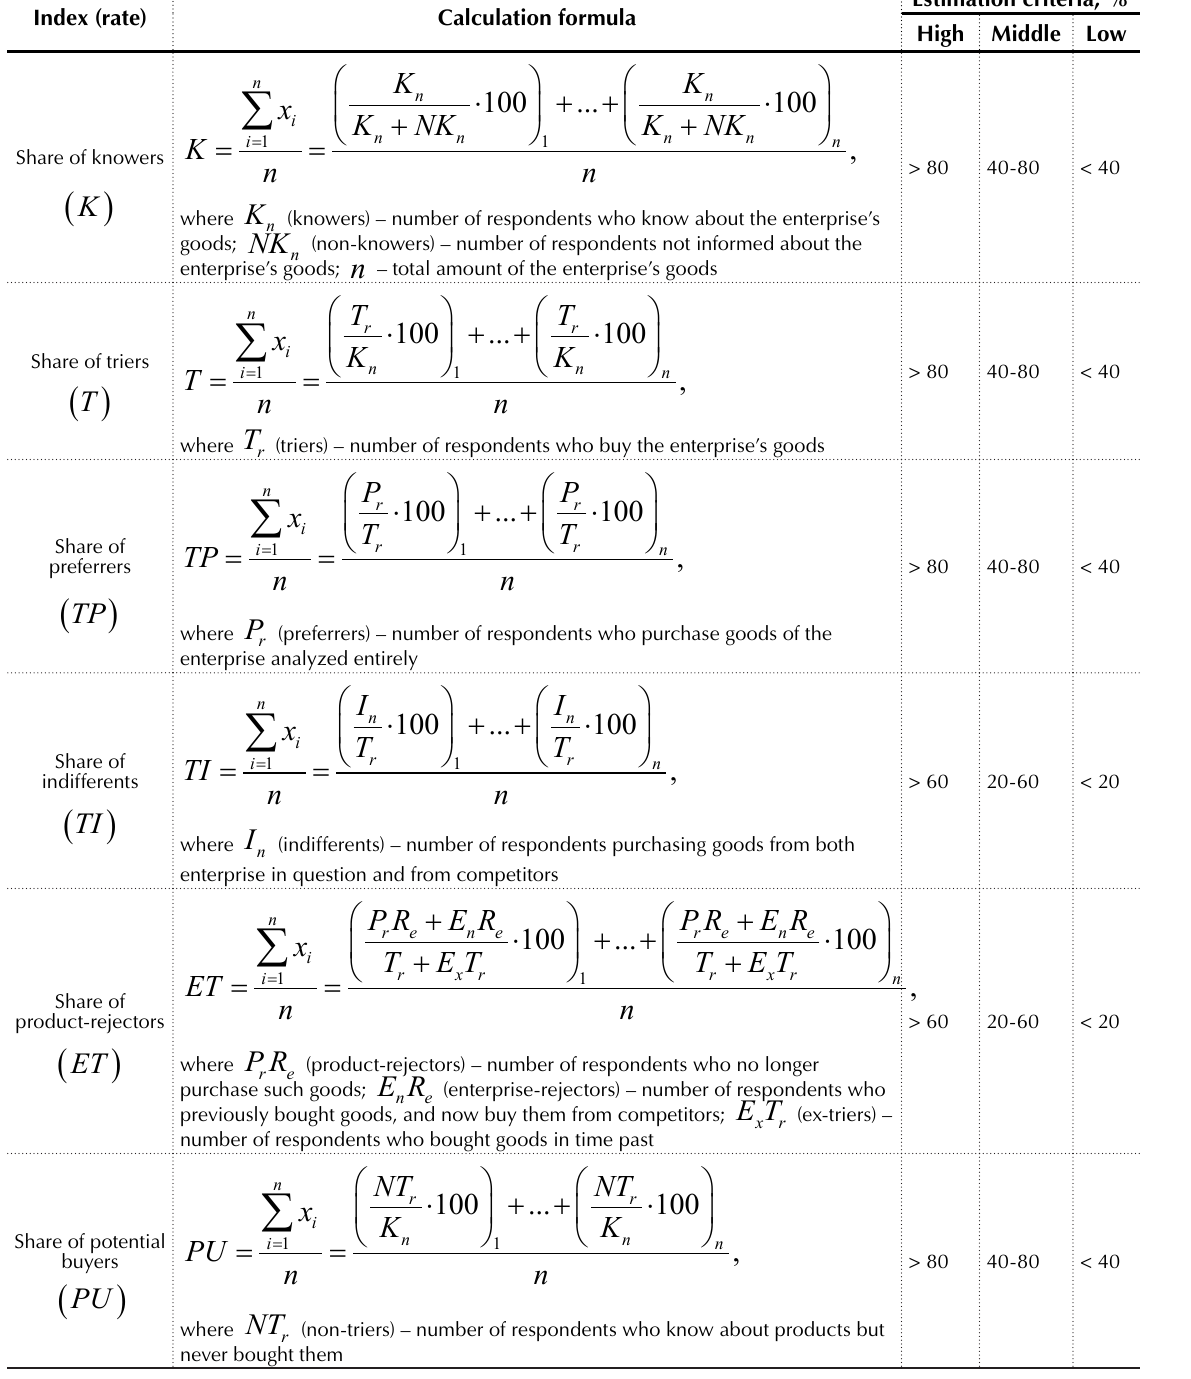
Estimation criteria, % High Middle